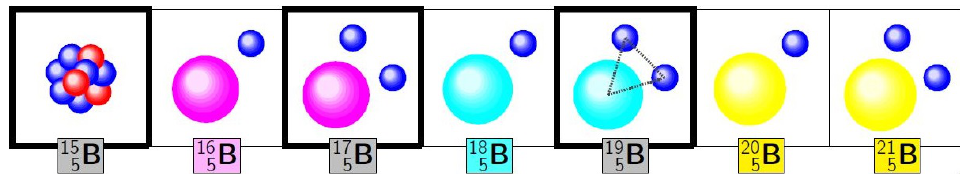
Figure 2: The boron chain from A = 15 to 21. The bound isotopes are marked within a thick frame, and the different number of clusters display the dominant structure of the corresponding ground states, from the 15 nucleons of 15 B to the two- and three-body structures of all the heavier